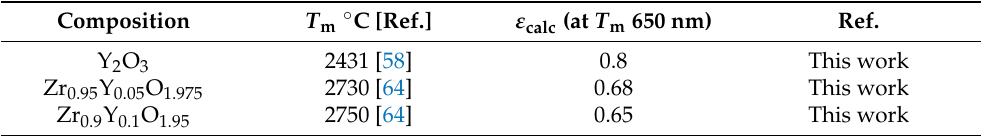
Table 3. Emissivity values calculated from assumption that the recalescence peak reaches the melting temperature ( T m